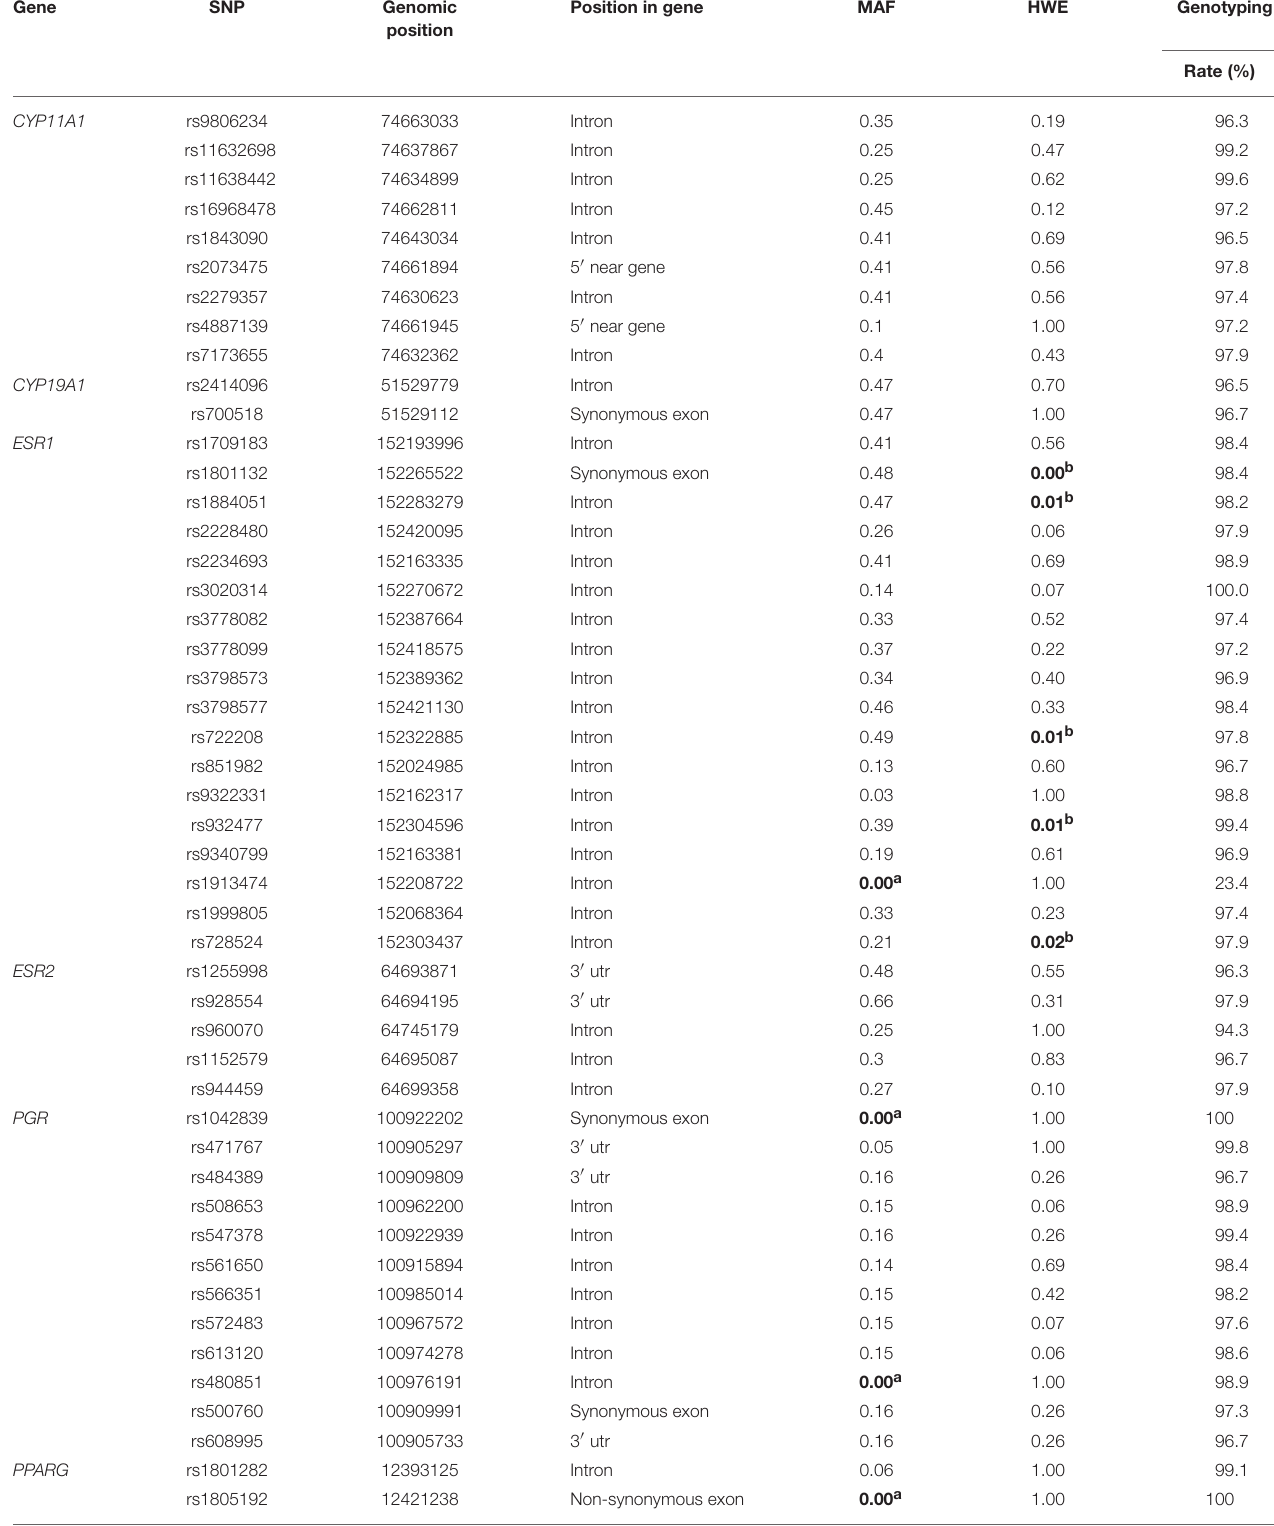
TABLE 2 | Information about minor allele frequency and Hardy-Weinberg equilibrium at selected SNPs. Gene SNP Genomic